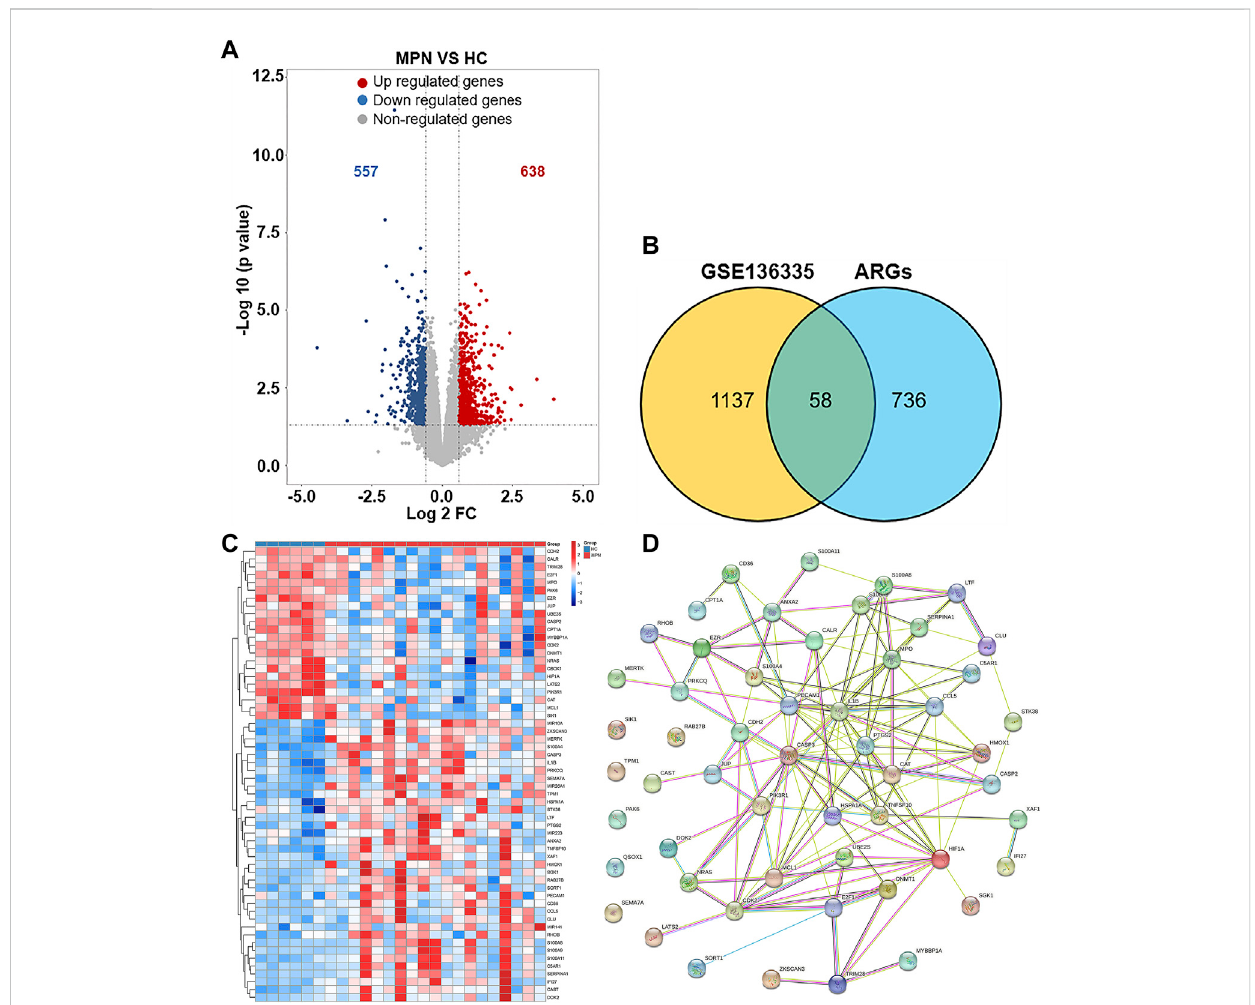
FIGURE 2 Screening of differentially expressed anoikis-related genes (ARGs) in MPN patients and healthy controls. (A) Volcano plot of genes differentially expressed between MPN patients and healthy controls in the GSE136335 dataset. Blue nodes represent downregulation in MPNs; red nodes represent upregulation; and grey nodes represent no signi fi cant difference from controls. (B) Intersection of differentially expressed genes (DEGs) in the GSE136335 and anoikis genes. The count on the left (1,137 genes) refers to DEGs unique to GSE136335; the count in the middle (58 genes) refers to anoikis-related DEGs; and the count on the right (736 genes) refers to unique to anoikis genes. (C) Heat map of 58 anoikis-related DEGs. (D) Protein – protein interaction (PPI) network of differentially expressed anoikis